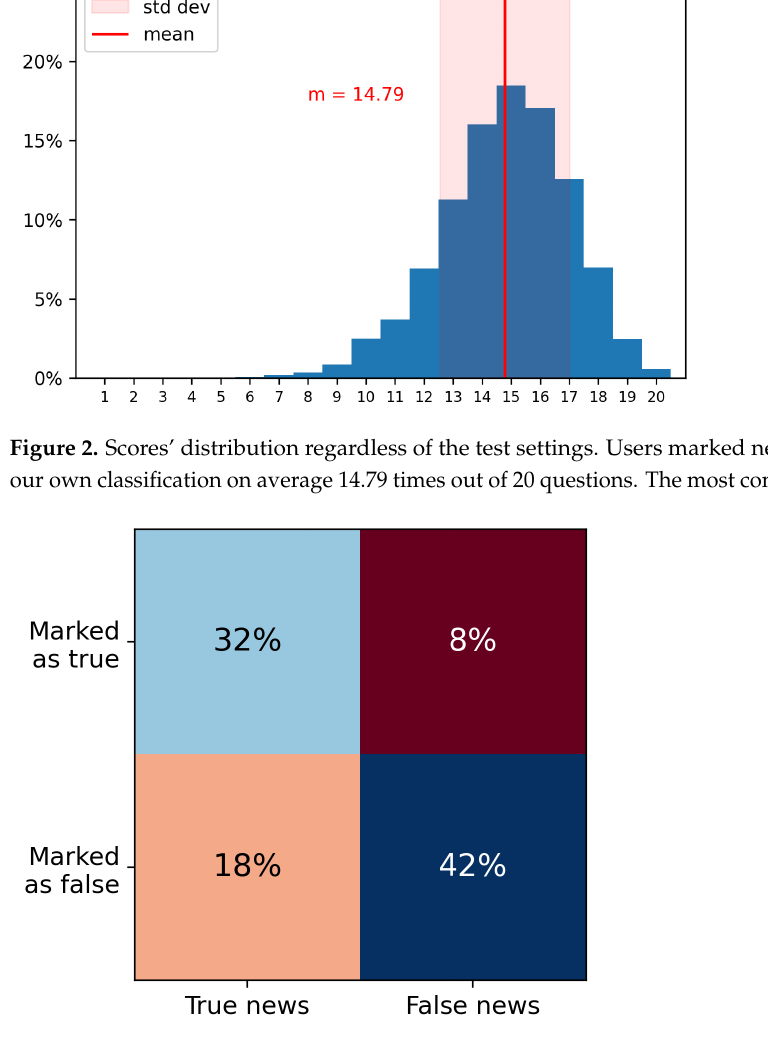
Figure 3. Users ratings’ confusion matrix. Users rated news as false 60% of the times, i.e., marking even some true items as false. True news have often been mistaken for